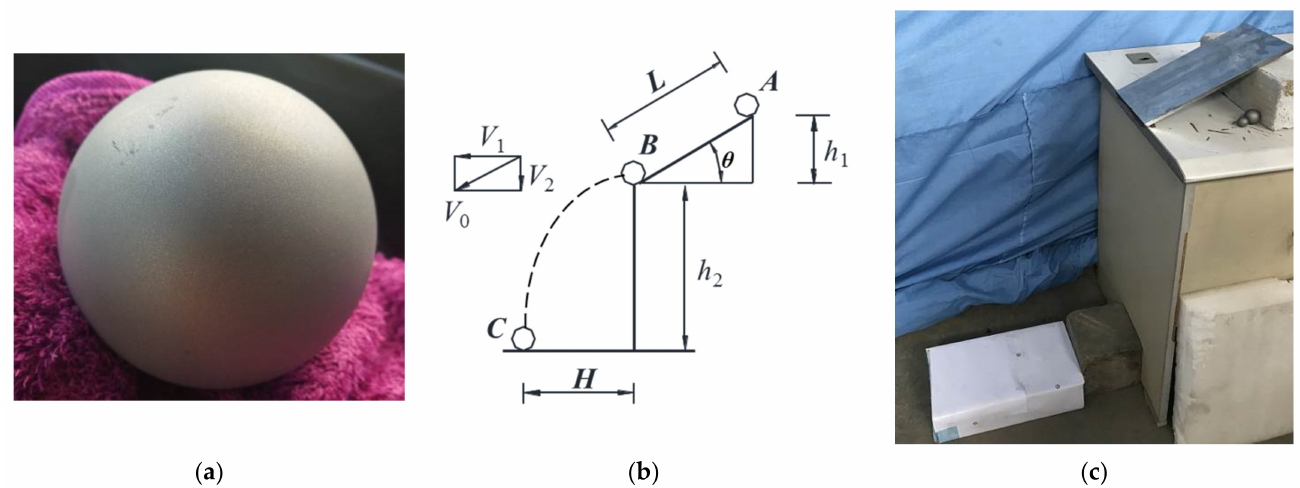
Figure 12. ( a ) Schematic diagram of the rolling ball; actual measurement of rolling friction coefficient between ( b ) schematic diagram and ( c ) actual